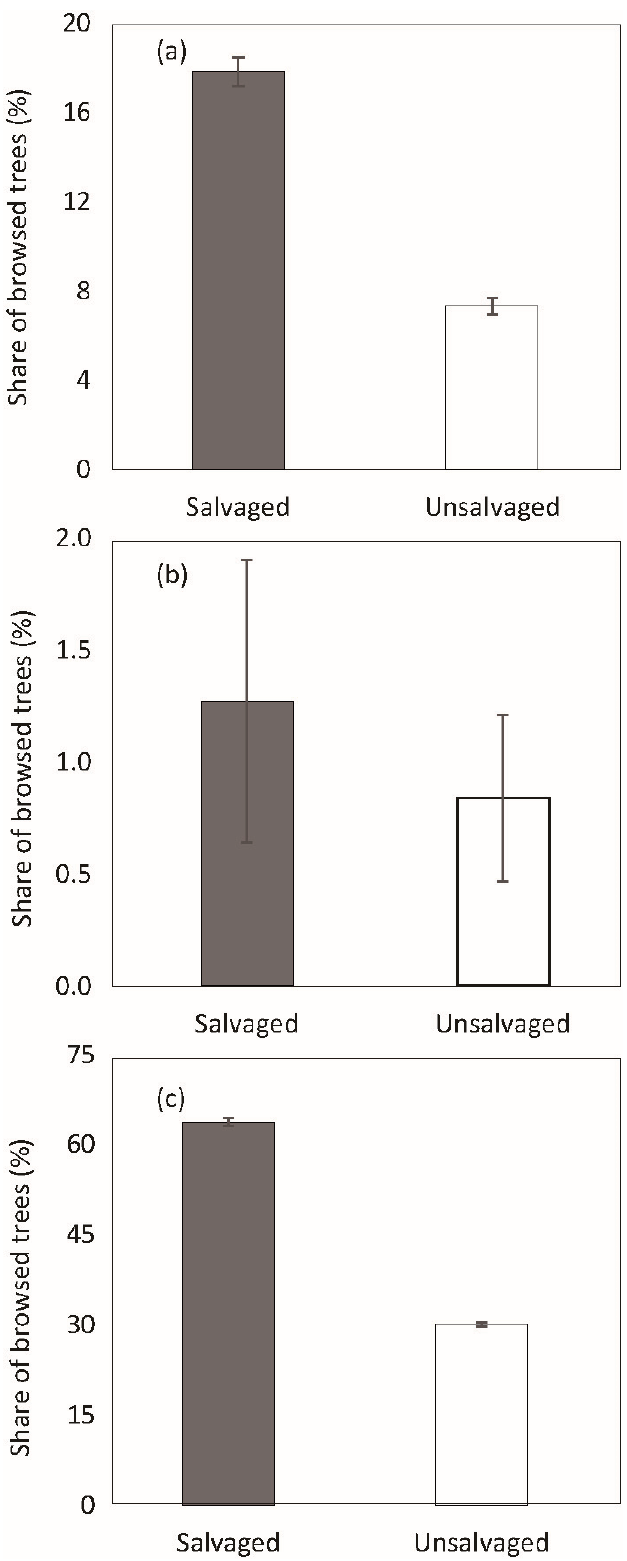
Figure 5. Share of browsed trees at salvaged and unsalvaged monitoring plots (MPs) for all tree species together ( a ), Norway spruce ( b ) and common rowan ( c ); the High Tatra Mts. in 2019. Differ- ences between salvaged and unsalvaged MPs were tested with an LSD test. Significant differences were confirmed for all species and common rowan (in both cases p < 0.001), but not for Norway spruce ( p = 0.628). Error bars show standard errors.